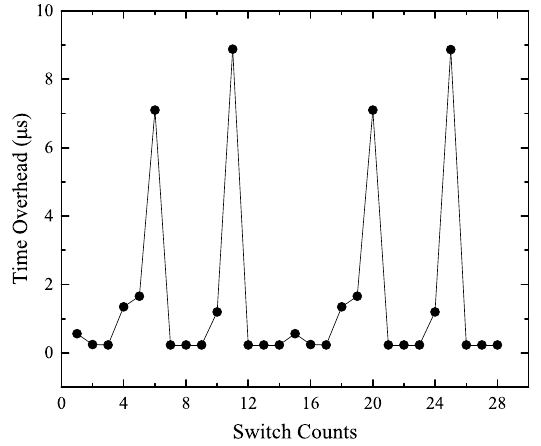
Figure 4. Context switch time overhead of Mxm.